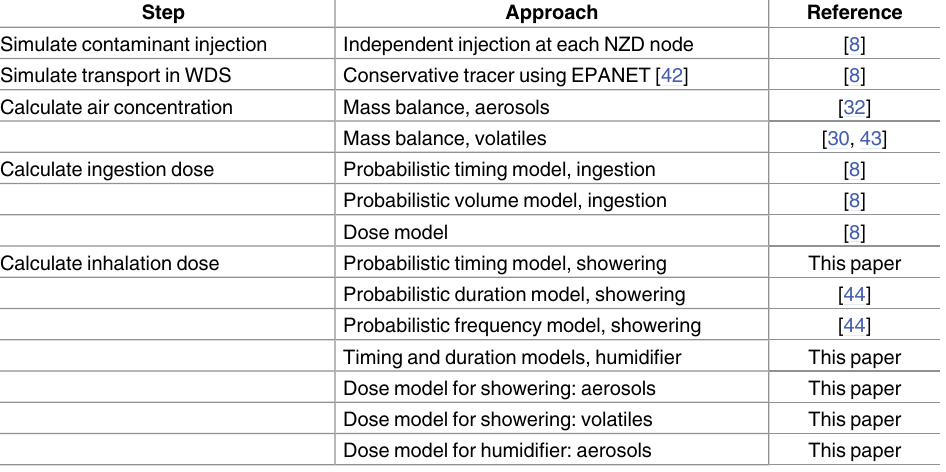
Step Approach Reference Simulate contaminant injection Independent injection at each NZD node Simulate transport in